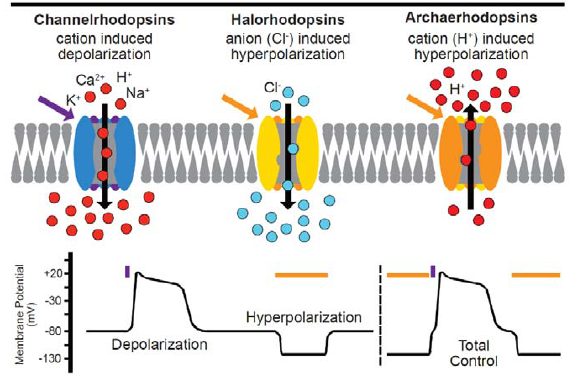
Figure 3. A summary of optogenetic actuators. Depolarizing channelrhodopsins, e.g., ChR2, open in response to light in the blue ‐ green spectrum allowing positively ‐ charged ions into the cell, raising the membrane potential and triggering the depolarization threshold. Conversely, inhibitory channels like Halorhodopsin (which pumps negatively ‐ charged ions in) or Archaerhodopsin (which pumps protons out) hyperpolarize excitable membranes. Inhibitory channel activity is controlled by light in the green ‐ red spectrum. The lower panel stylizes the effect on cell membrane potential by blue or orange pulses of light to depolarize, or hyperpolarize the cell. The two approaches can be combined to hyperpolarize, and then activate, the cell [95]. A number of reporter strategies discussed in this review can be integrated with stimulatory optical control [42,60,68,69,78,81,83,85,97].